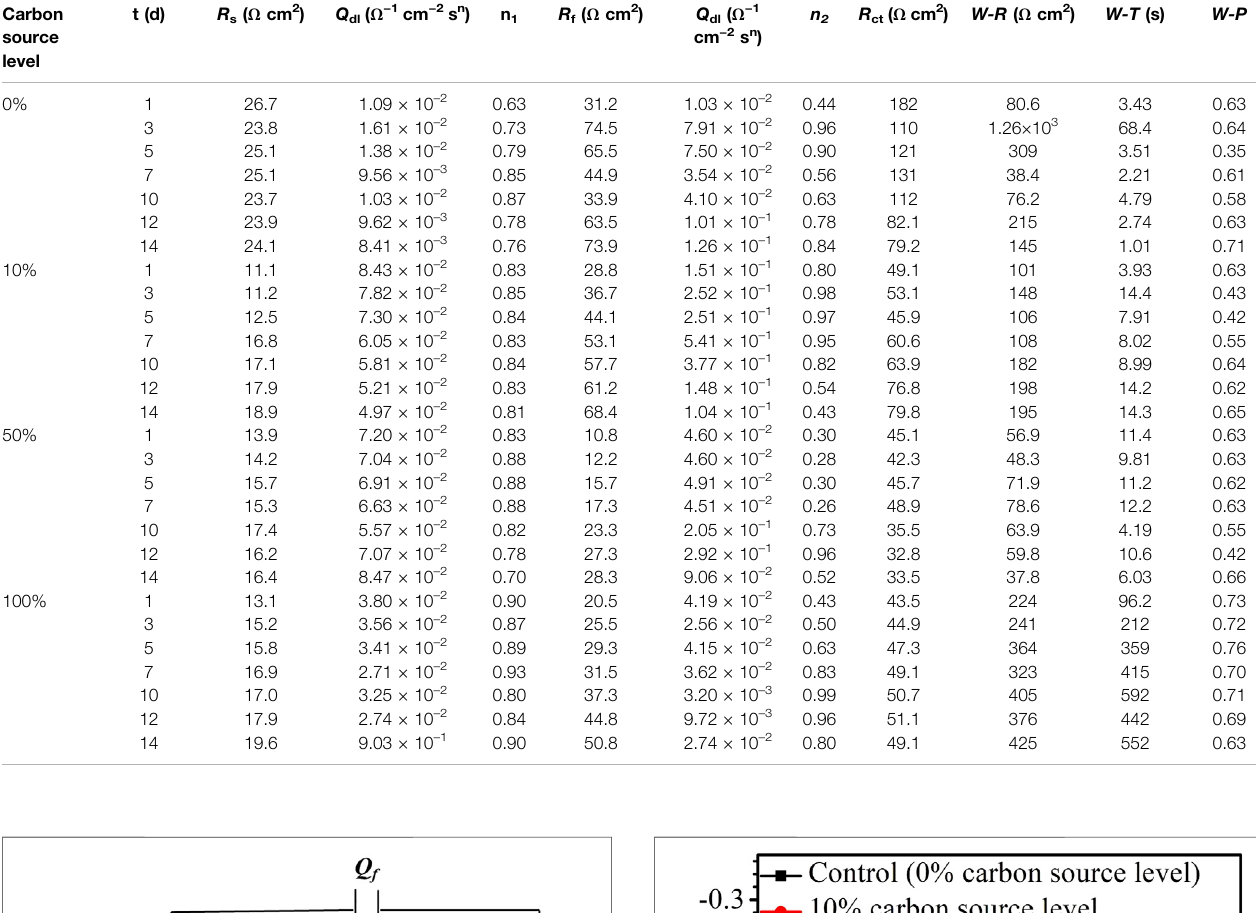
TABLE 3 | Electrochemical parameters obtained from fi tting EIS spectra in Figure 7 . Carbon source level